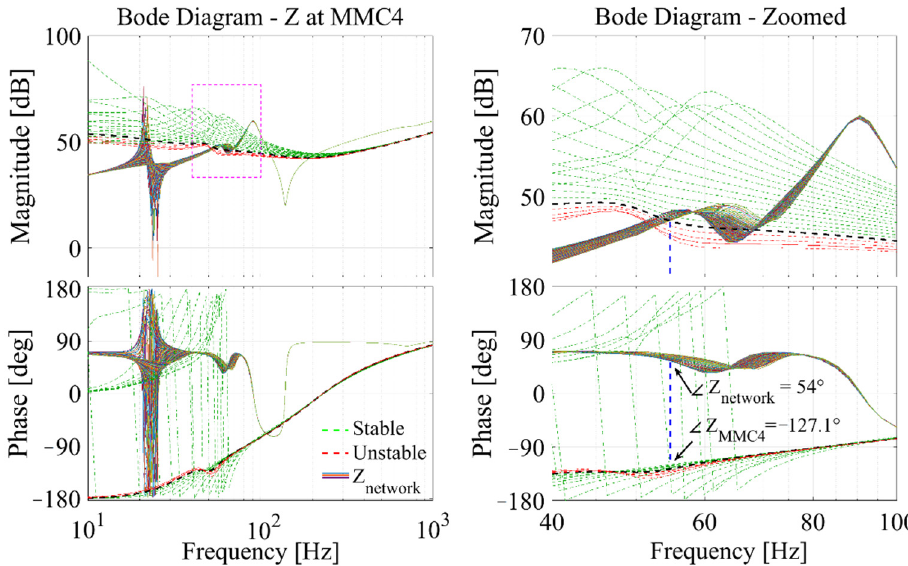
Figure 12. Impedance of MMC station 4 and network impedance seen from the terminals of MMC station 4.